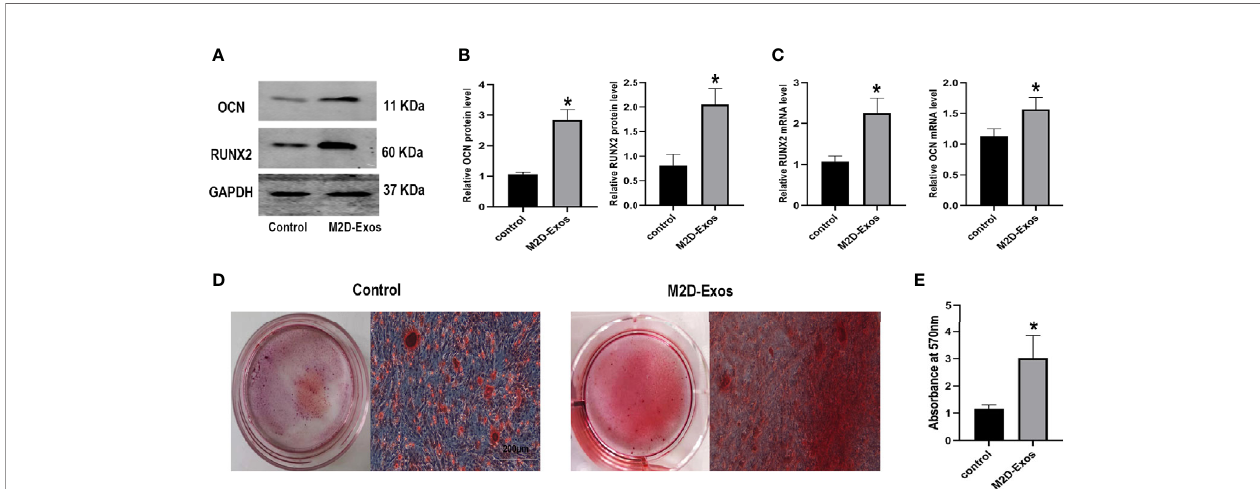
FIGURE 2 | Exosomes derived from M2 macrophages enhanced osteogenic differentiation of BMSCs. (A, B) Osteogenic proteins, OCN and RUNX2, were measured by western blotting analysis and quanti fi ed, Control group was BMSCs treated in osteogenic inducer. (C) Osteogenic genes, OCN and RUNX2, were measured by RT-PCR analysis, Control group was BMSCs treated in osteogenic inducer. (D) Alizarin red staining was used to measure the formation of bone nodules in BMSCs after treated by PBS (control group) or M2D-Exos for 14 days. Scale bar = 200 µm. (E) The statistical data of Alizarin red-mediated calcium staining. *p < 0.05 compared to the control group. Control group was BMSCs treated in osteogenic inducer.